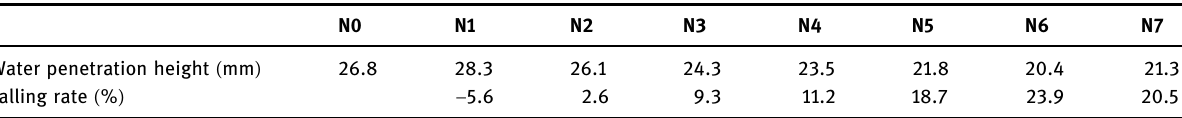
Table 10: Water penetration